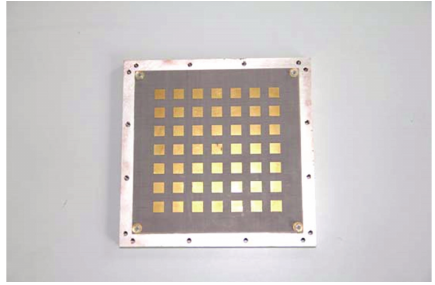
Figure 8: Front view of the fabricated